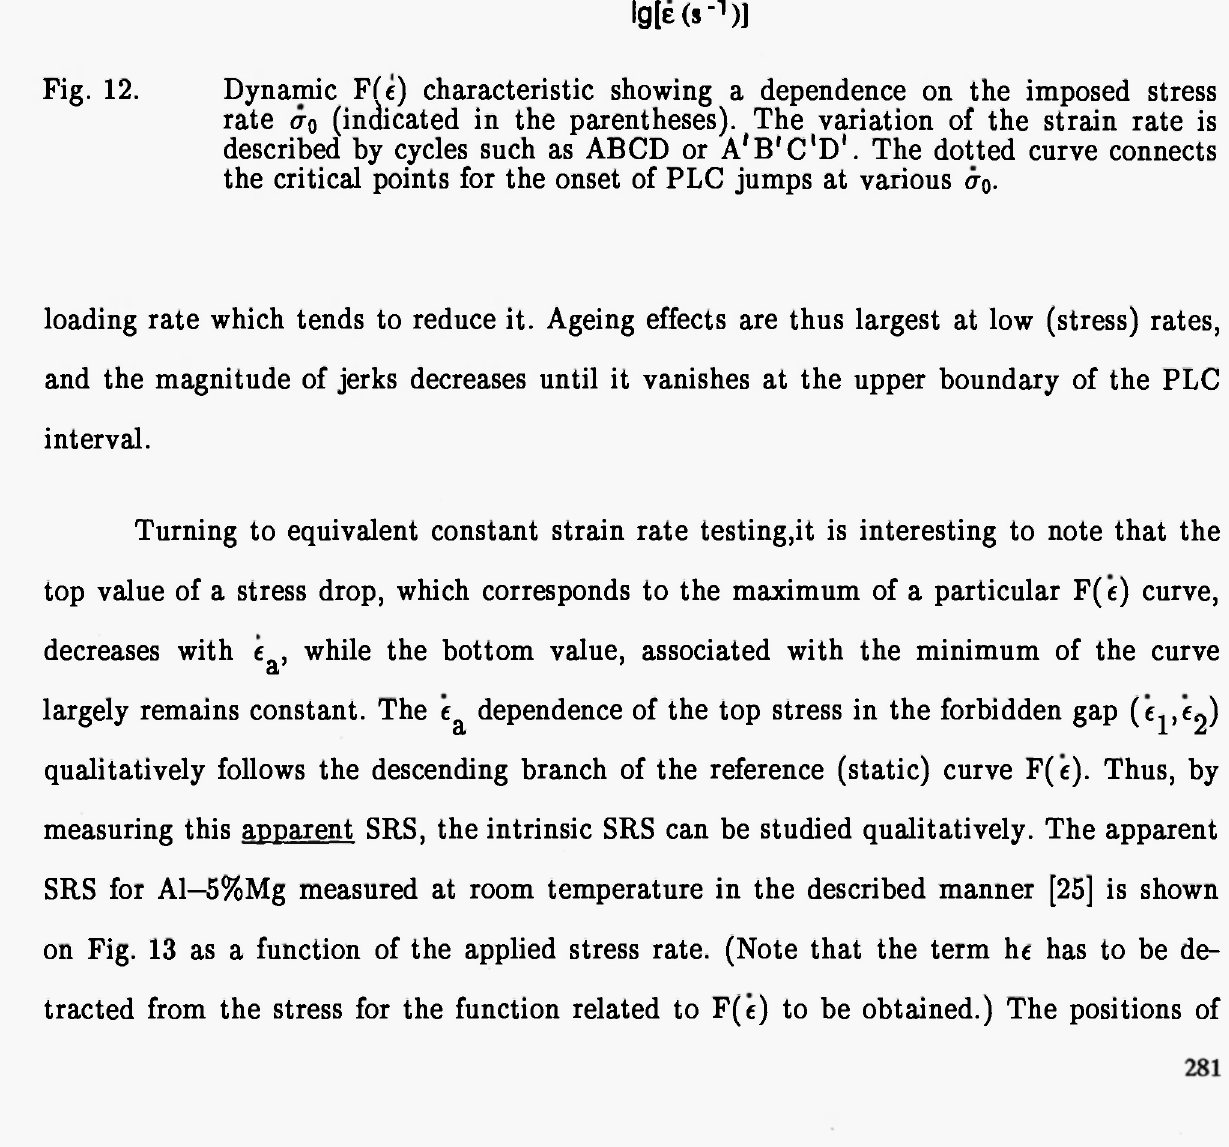
Dynamic Fie) characteristic showing a dependence on the imposed stress rate σο (indicated in the parentheses). The variation of the strain rate is described by cycles such as ABCD or A'B'C'D 1 . The dotted curve connects the critical points for the onset of PLC jumps at various